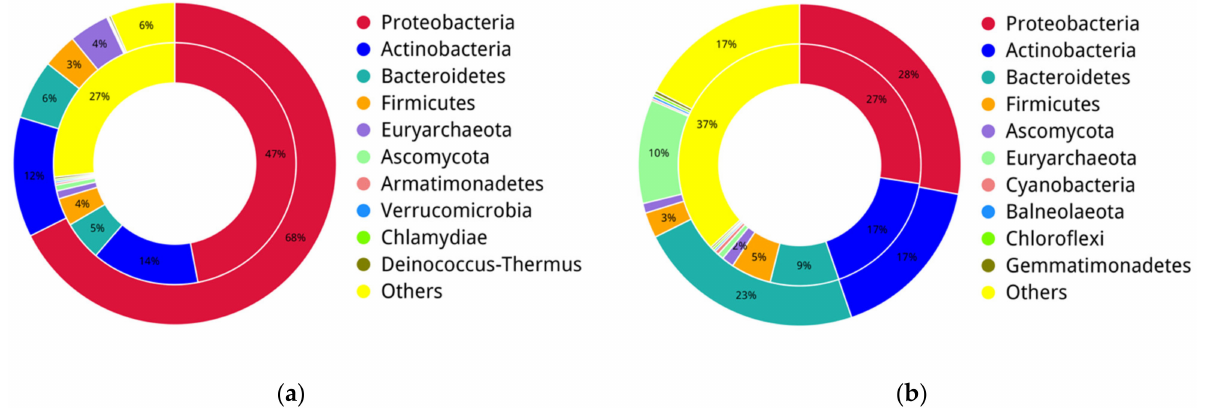
Figure 6. Relationship between ARGs distribution with taxonomic compositions at the phylum level in SZ ( a ) and WH ( b ). The inner circle is the ARG distribution for each phylum. The outer circle is the taxonomic composition at the phylum